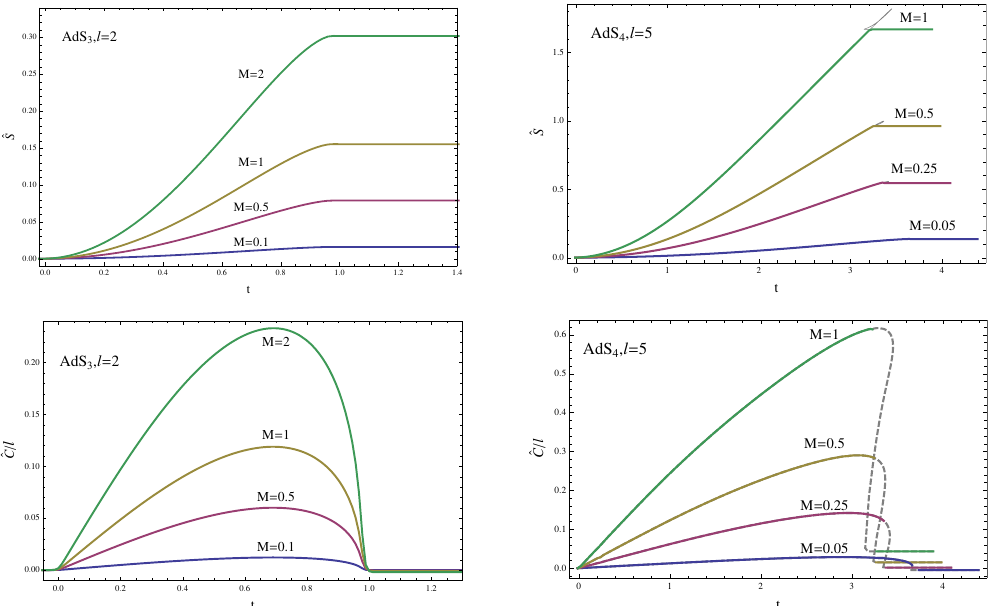
Figure 12 . The dependence of the entanglement entropy and the subregion complexity density ^ C=l on M . We (cid:12)x v 0 = 0 : 01 here. Note that there is still a sudden drop of complexity in the evolution when M = 0 : 05 in the right lower